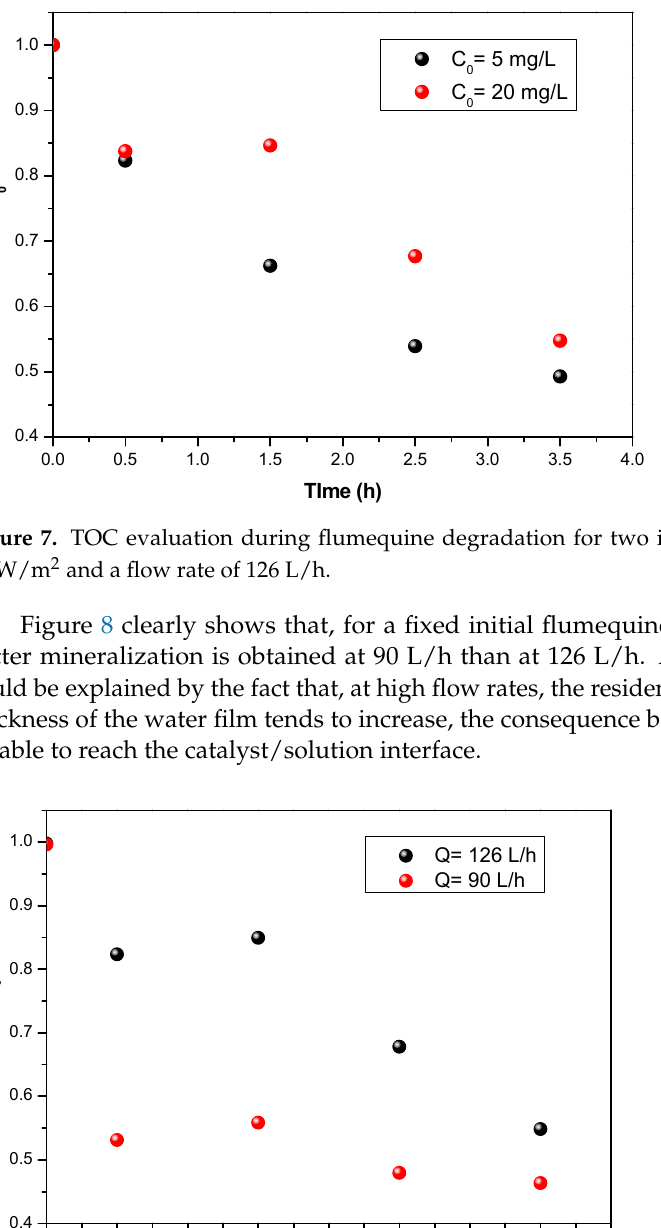
Figure 6. Evolution of the concentration of flumequine during its photocatalytic degradation for an initial concentration of 5 mg/L, three light intensities, and a flow rate of 29 L/h.